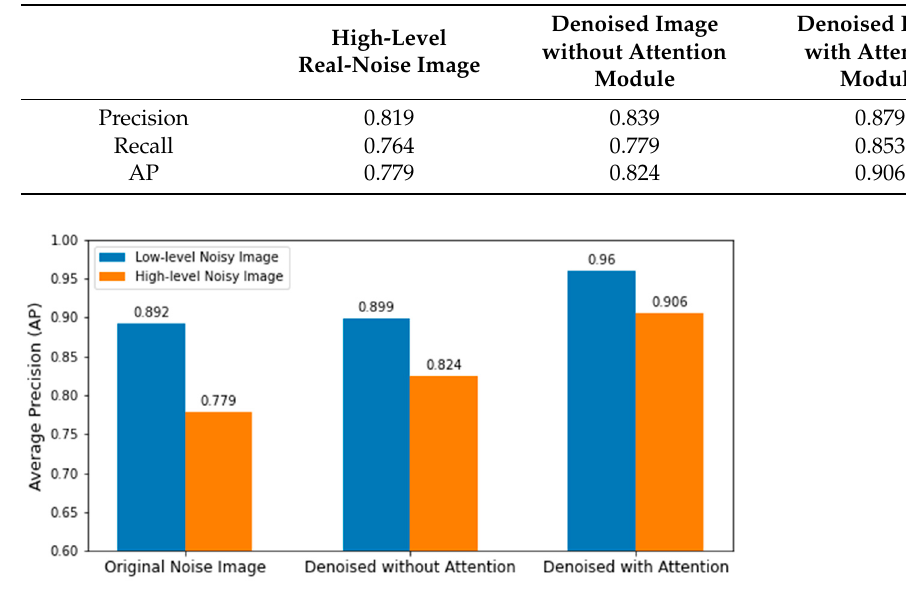
Figure 9. Comparison of average precisions on different level real-noise images and the corresponding denoised images using the denoising model with and without attention module.